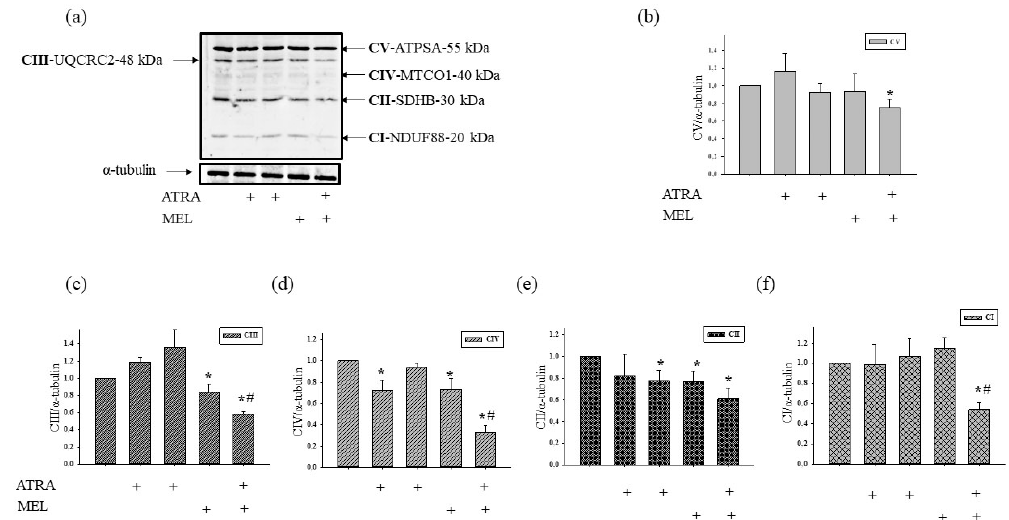
Figure 6. The effect of MEL and ATRA on the mitochondrial respiratory chain complexes in HL-60 cells. Cells were seeded in a 96-well plate at a density of 5 × 10 3 cells per well and treated with 1 μ M ATRA (column 2), and 10 nM ATRA (columns 3) and 1 mM MEL (column 4), and MEL in combination with 10 nM ATRA (column 5); untreated cells (control, column 1). Protein samples were extracted and subjected to Western blotting. Changes in mitochondrial complexes were detected using, the Total OXPHOS Rodent WB Antibody Cocktail. The immunodetection of α -tubulin was used as a loading control. ( a ) Immunostaining with OXPHOS antibody cocktail and α -tubulin; ( b – f )-quantification of immunostaining using computer-assisted densitometry. Bar graphs represent the levels of appropriate complexes (I–V) in relative units. The protein level in a cell lysate without any addition was taken to be unity and served as a control. The data are presented as means ± S.D. of five separate experiments. * p < 0.05 significant difference in protein level in comparison with the corresponding control, # p < 0.05 significant difference in the protein level compared to the value obtained in the presence of MEL alone.